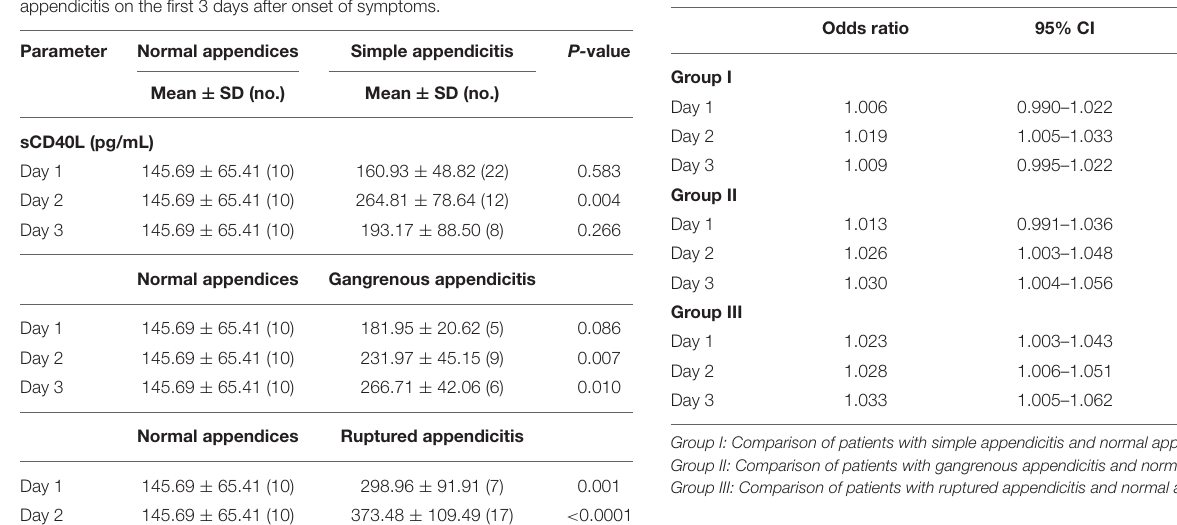
TABLE 2 | Logistic regression analysis of sCD40L for the diagnosis of acute appendicitis in the subgroups on days